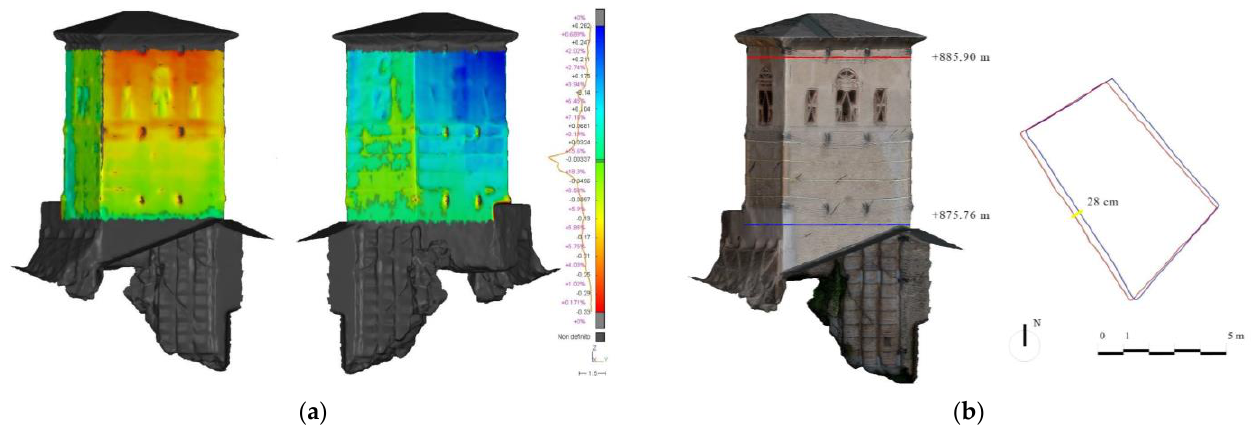
Figure 15. ( a ) Deformation evaluation based on the 3D mesh model with deviation analysis between the tower mesh and the profile at the base extruded along the vertical, underlining the off-lead of the bell tower; and ( b ) mesh profile at the base (blue) and mesh profile at the top of the tower (red).